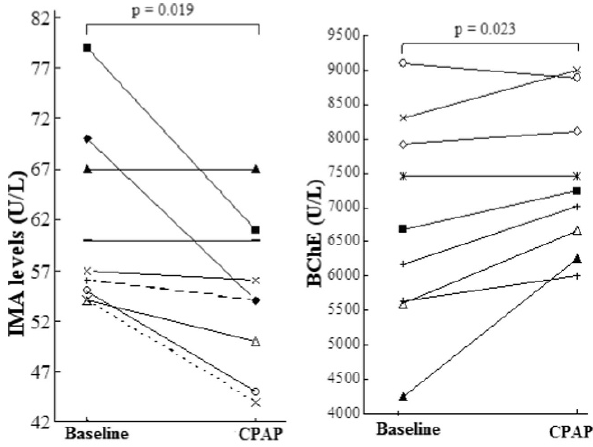
Figure 2 - The serum ischemia-modified albumin levels positively correlated with apnea-hypopnea index ( r =0.462, p =0.008) in the obstructive sleep